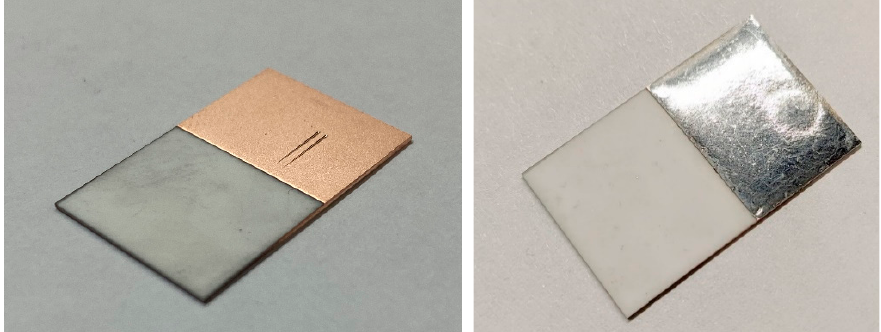
Figure 9. Photographs of prepared CuO + Cu coating after scratch testing and after soldering.